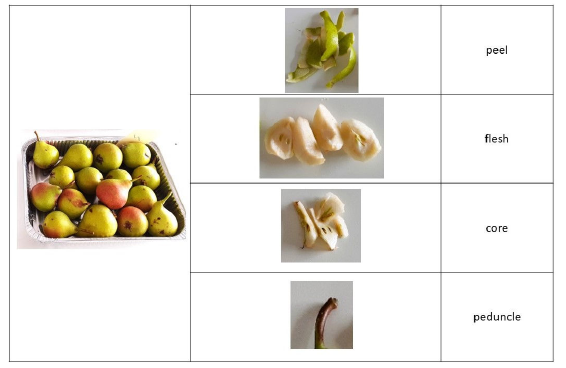
Figure 4. Fresh fruit partitioning into the four components for subsample preparation and storage before chemical analysis.